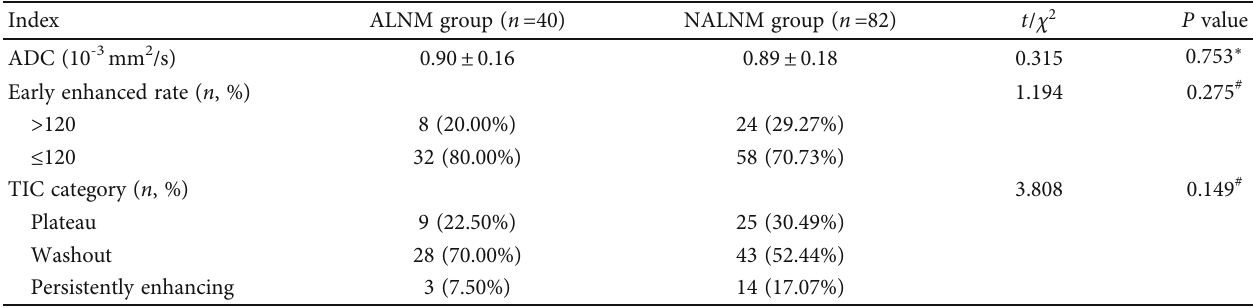
Table 3: Comparison of MRI parameters between the two